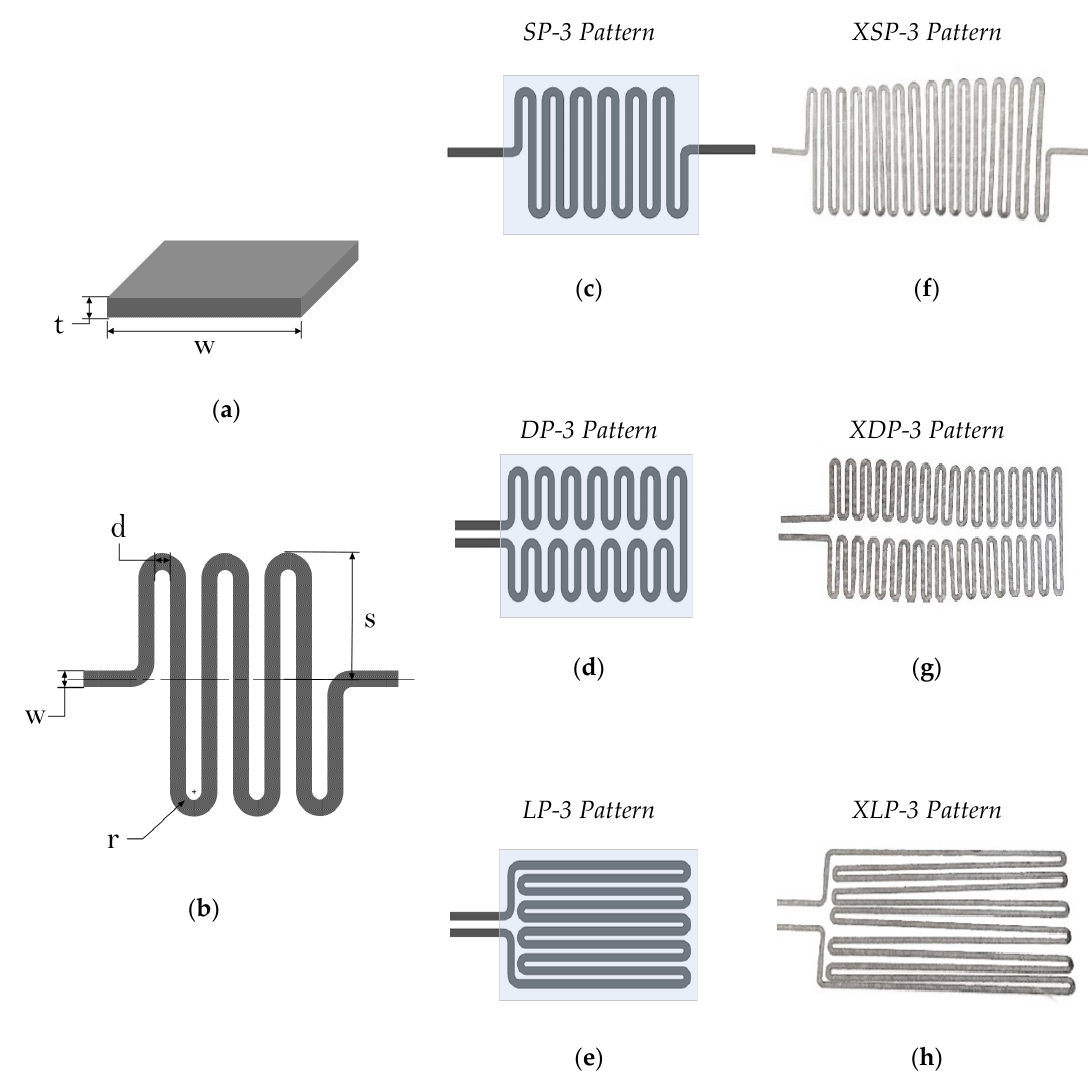
Figure 5. Resistive track heating element. ( a ) Cross-section of a fabric channel. Thickness ( t ) is determined by the fabric, and width ( w ) is determined by the design of the heater; ( b ) geometric parameters of heating track; ( c ) single pass track design; ( d ) double pass track design; ( e ) lengthwise coiled track design; ( f ) large single pass track design; ( g ) large double pass track design; ( h ) large lengthwise coiled track design. Table 2. Resistive track geometric parameters (see Figure 5b).